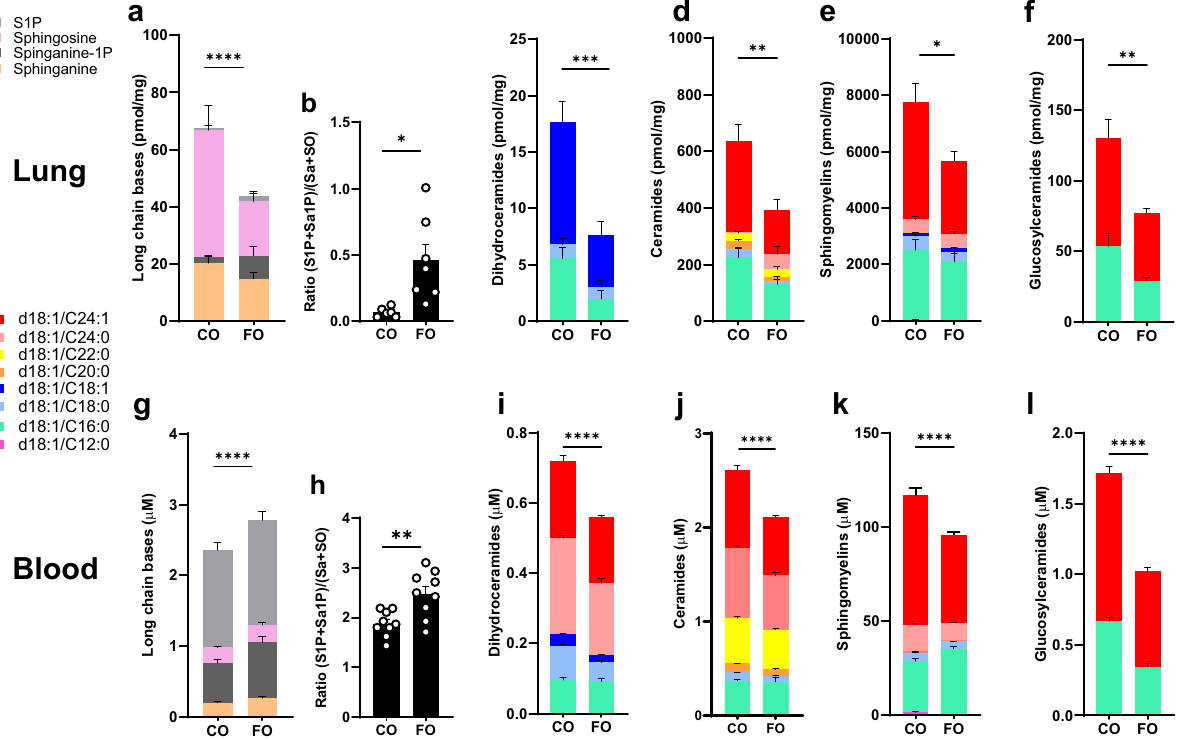
Figure 4. N-3 PUFA enriched diet decreases ceramides and sphingomyelins in lungs and blood cells. Sphingolipids in lung ( a – f ) and whole blood ( g – l ) from BALB/c mice that were fed either FO or CO diet for 8 weeks. ( a , g ) Long chain bases. ( b , h ) Ratios of the two phosphorylated long chain bases sphingosine-1P (S1P) and sphinganine-1P (Sa1P) to sphinganine and sphingosine. ( c , i ) Dihydroceramides. ( d , j ) Ceramides. ( e , k ) Sphingomyelins. ( f , l ) Glucosylceramides. Data are representative of 3 independent experiments with 5–6 mice per group. *p < 0.05. **p < 0.001, ***p < 0.0001, ****p < 0.00001 (two-way ANOVA with Tukey’s multiple comparisons